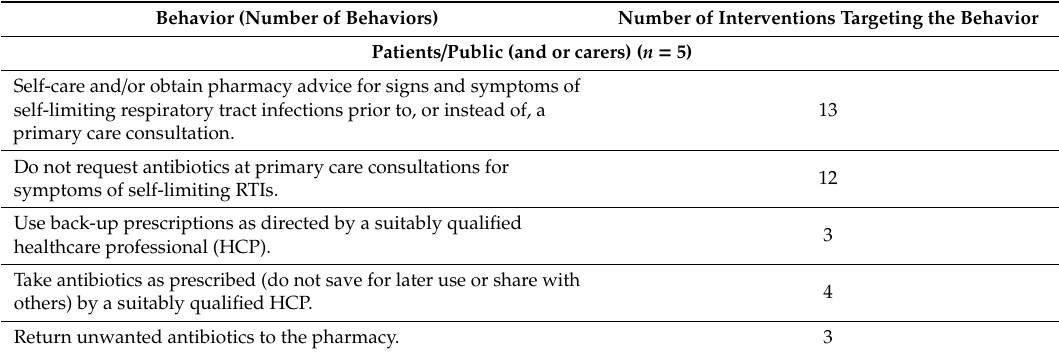
Table 1. Behaviors related to antibiotic prescribing for respiratory tract infections (RTI) in primary care. Behavior (Number of Behaviors) Number of Interventions Targeting the Behavior Patients / Public (and or carers) ( n =